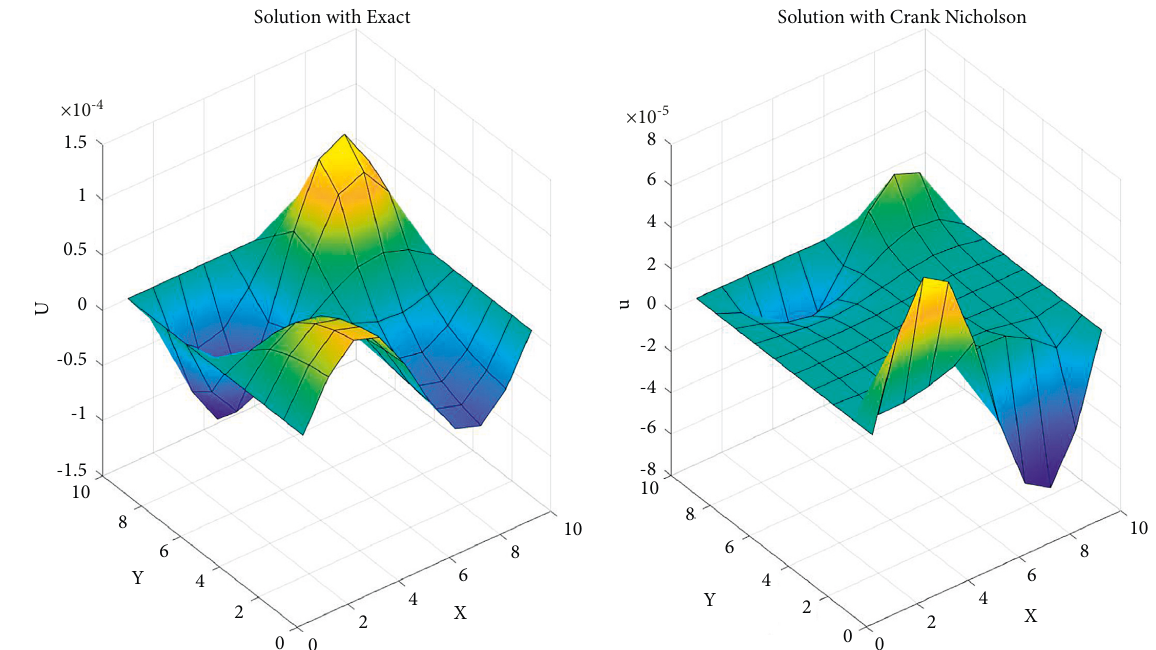
Figure 2: Analytical and approximate results of the CN scheme at 10 × 10 grid size, time � 2, time step � 0 . 0001, and ϵ � 0 . 1.